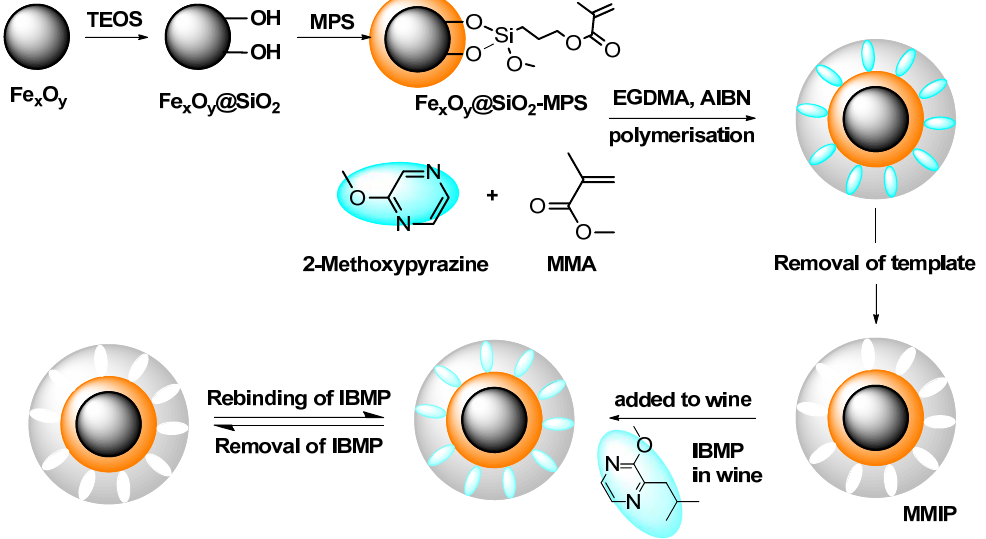
Figure 8. Schematic showing the preparation steps used in an attempt to produce MMIPs. TEOS: tetraethoxysilane; MMA: methyl methacrylate; EGDMA: ethylene glycol dimethacrylate; AIBN: 2, 2 ′‐ azobisissobutyronitrile.